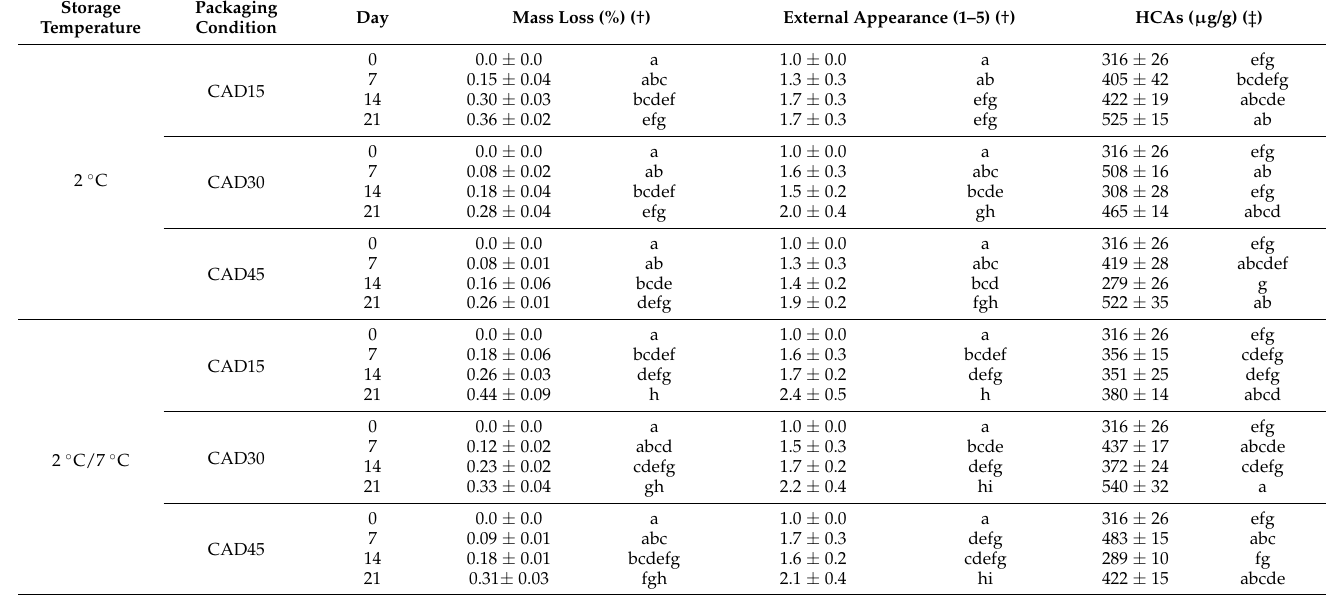
Table 1. Mass loss, external appearance, and hydroxycinnamic acids content (HCAs) evolution of broccoli florets packaged in films with different levels of micro-perforation (CAD15, CAD30 and CAD45) throughout storage at 2 ◦ C and 2 ◦ C/7 ◦ C. Data are expressed as means ± standard error. Same letter in the same column means no significant differences according to Tukey’s test ( p < 0.05).